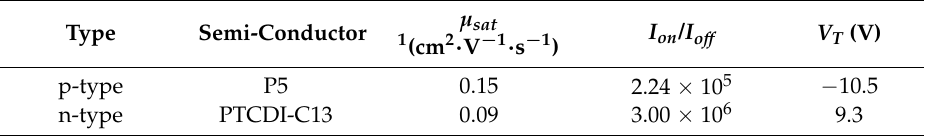
Figure 4. Performance of OTFT devices on copolymer dielectric films. OTFT transfer characteristics for ( a ) P5, ( c ) PTCDI-C13, and OTFT output characteristics for ( b ) P5, ( d ) PTCDI-C13. The channel width and length are 1000 and 100 µ m, respectively. Table 2. TFT Device Performance Parameters based on P5 and PTCDI-C13 Semiconductors on Copolymer Dielectric. ( µ sat : carrier mobility, I on /I off : current on/off ratio, V T ; threshold voltage).